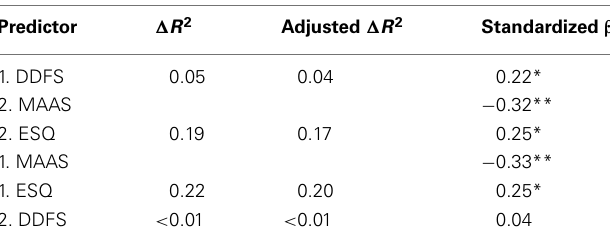
Table 7 | Hierarchical multiple regression analyses of Study 2